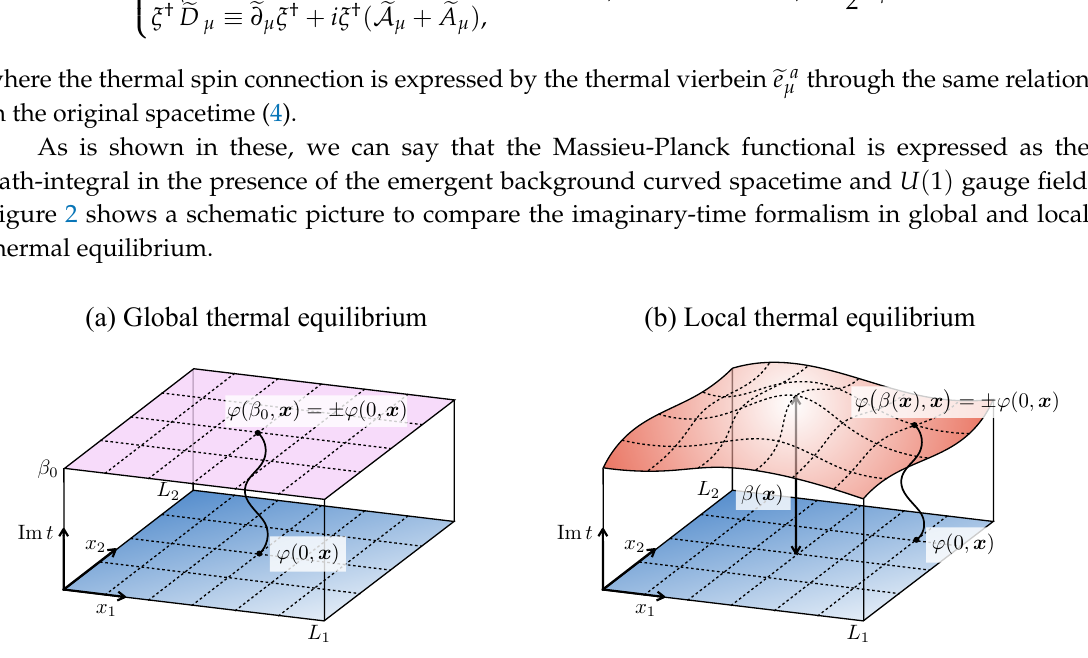
Figure 2. A comparison of the imaginary-time formalism ( a ) in global thermal equilibrium and ( b ) in local thermal equilibrium. Effects of inhomogeneous local thermodynamic parameters such as the local temperature is completely captured in terms of the emergent curved geometry. The boundary condition corresponds to the boson or the ±